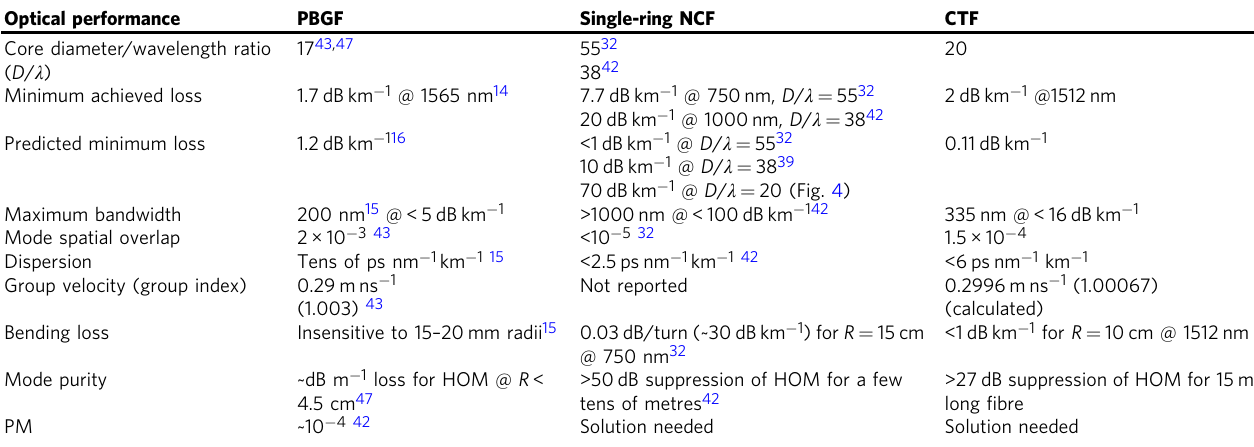
Table 1 Optical performance comparison of PBGF, single-ring NCF and CTF Optical